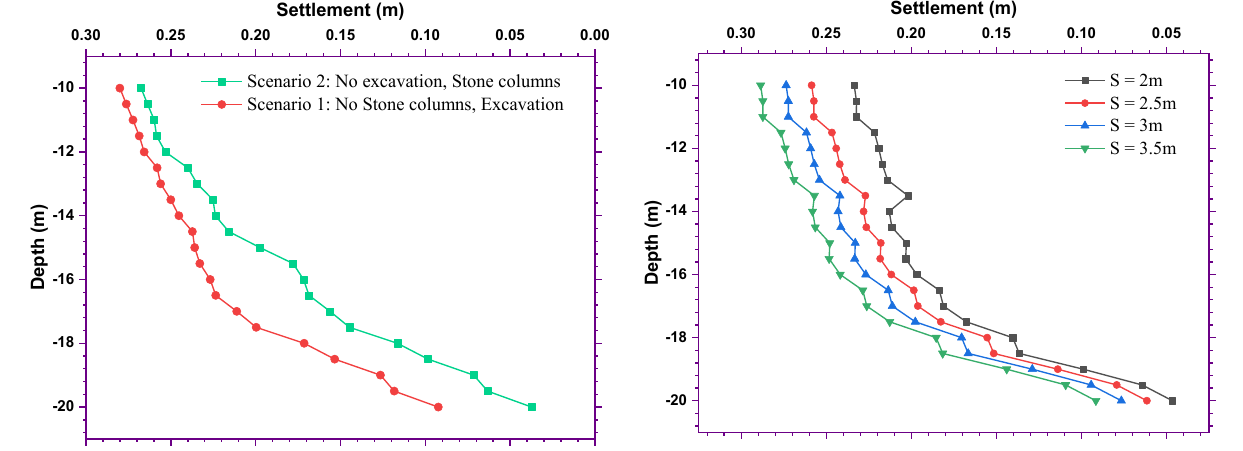
Figure 4: Effect of stone column spacing (S, taken as interaxial distance) on vertical settlements as a function of depth.